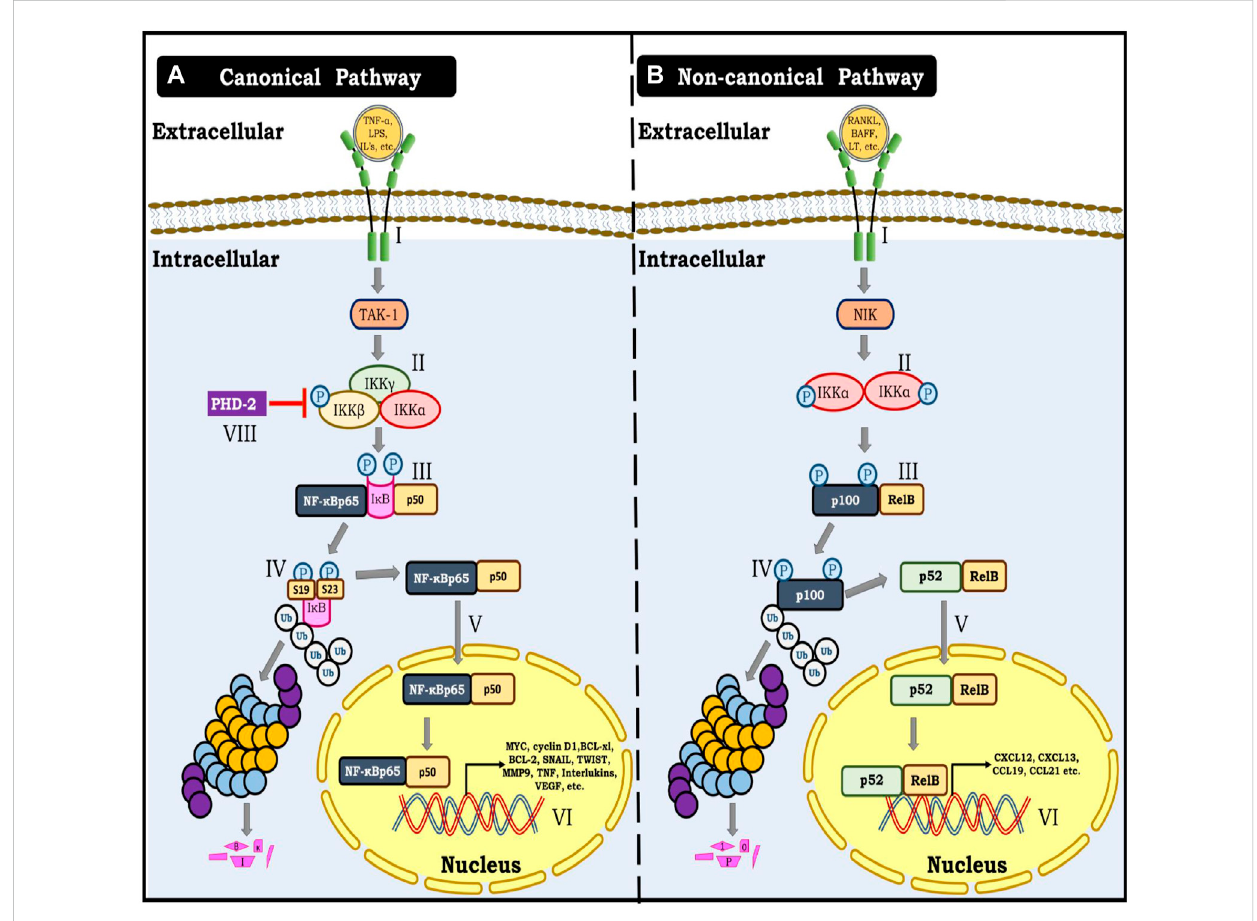
FIGURE 2 (A) Canonical NF- κ B pathway. I- Represent binding of TNF- α , Interleukins, Lipopolysaccharides and other cytokines with their speci fi c receptor resulting in activation of TAK kinase-1. II- Activation of TAK-1 result in phosphorylation of IKKB unit of the triad consisting of IKK α , IKK β and IKK γ . III- Phosphorylation of IKKB further result in phosphorylation of I κ B at Ser19 and Ser23. IV- This phosphorylation allows for ubiquitination and proteasomal degradationofI κ B.V-Thismodi fi cationrendersNF- κ Bdimer(p65andp50)freetotranslocatetothenucleus.VI-NF- κ Bdimer(p65andp50)further binds with speci fi c response elements on DNA and triggers gene transcription of several genes involved in angiogenesis, metastasis, migration and cellular proliferation. (B) Non- canonical NF- κ B pathway. I- denotes the binding of TNFR ligands to their respective receptors, which results in the activation of NF- κ B inducing kinase-1 (NIK). II- NIK phosphorylates IKK α , causing it to be activated. III- Finally, activated IKK α phosphorylates p100. IV- IKK α mediated phosphorylation of p100 marks it for ubiquitination and proteasomal processing to yield p52. V-p52 forms an active dimer with Rel B and translocates to the nucleus. VI- p52 and Rel B dimer bind to the DNA and cause gene